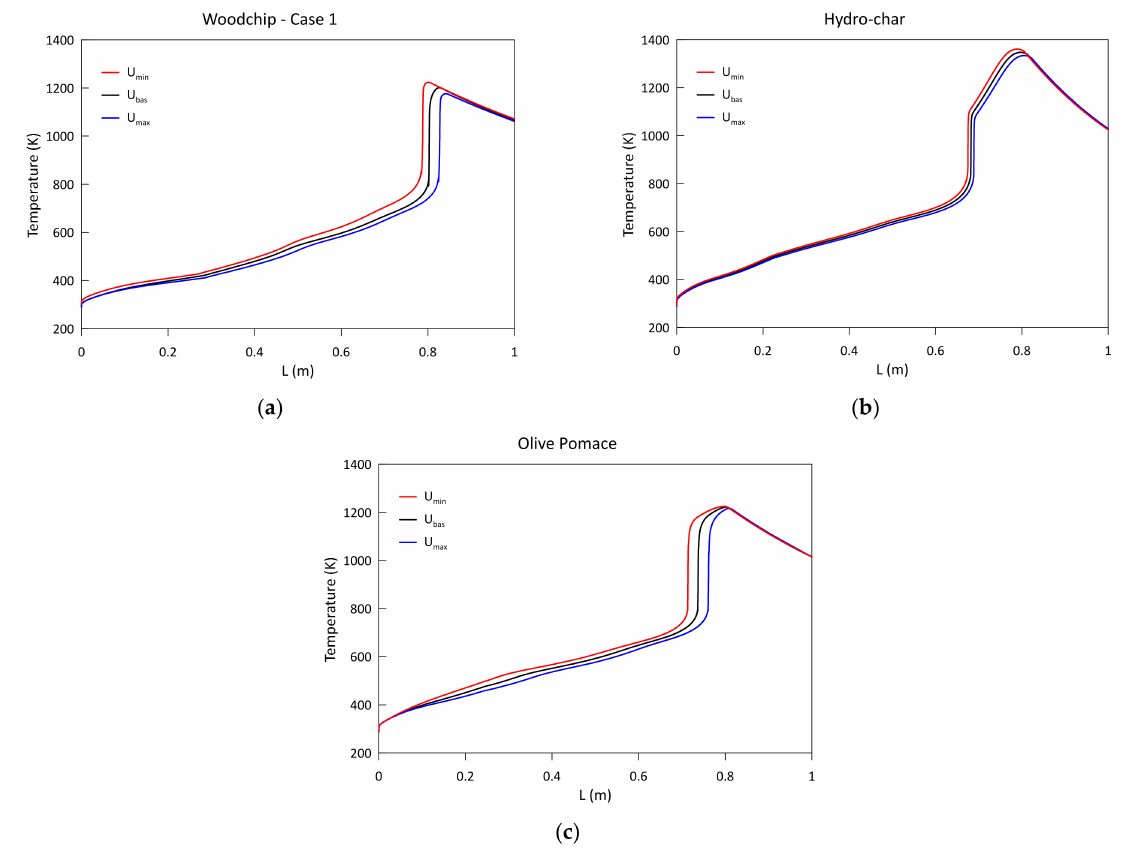
Figure 17. Temperature evolution along the reactor axis at different biomass/residual material initial moisture content levels for ( a ) woodchip case 1, ( b ) hydro-char from green waste, ( c ) olive pomace.